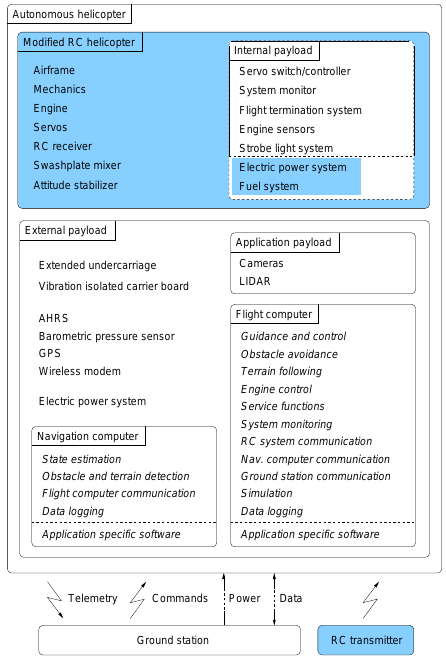
Figure 2: Components of the helicopter system. Components of a typical COTS RC helicopter are printed on blue